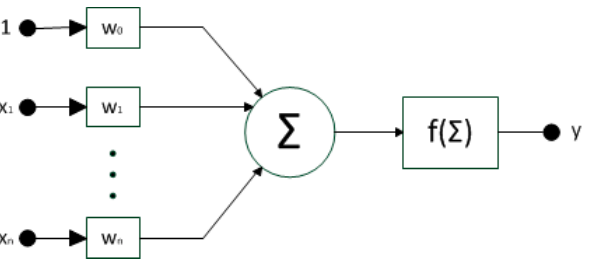
Figure 4. McCulloch and Pitts neuron model.